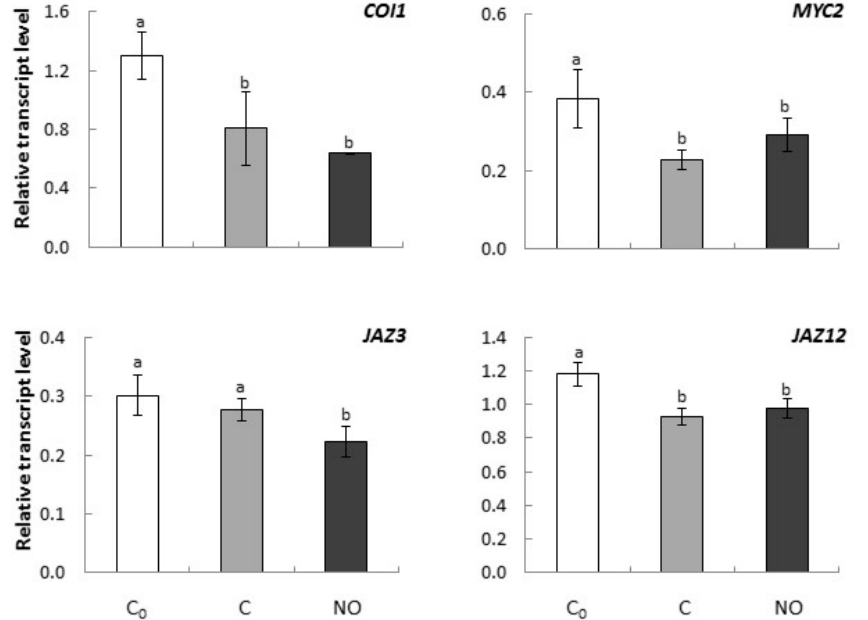
Figure 6. The relative expression level of genes encoding elements of JA transduction pathway ( COI1 , MYC2 , JAZ3 , JAZ12 ) in axes of apple embryos isolated after 24 h of seeds imbibition in water (C 0 ), in axes of embryos imbibed in water for 3 h after seed coat removal (C), in axes of embryos fumigated with NO for 3 h (NO). The expression of genes was normalized to UBI as a reference gene. Two technical replicates were performed for each four biological replicates. Error bars represent ± SD; a, b homogenous groups.